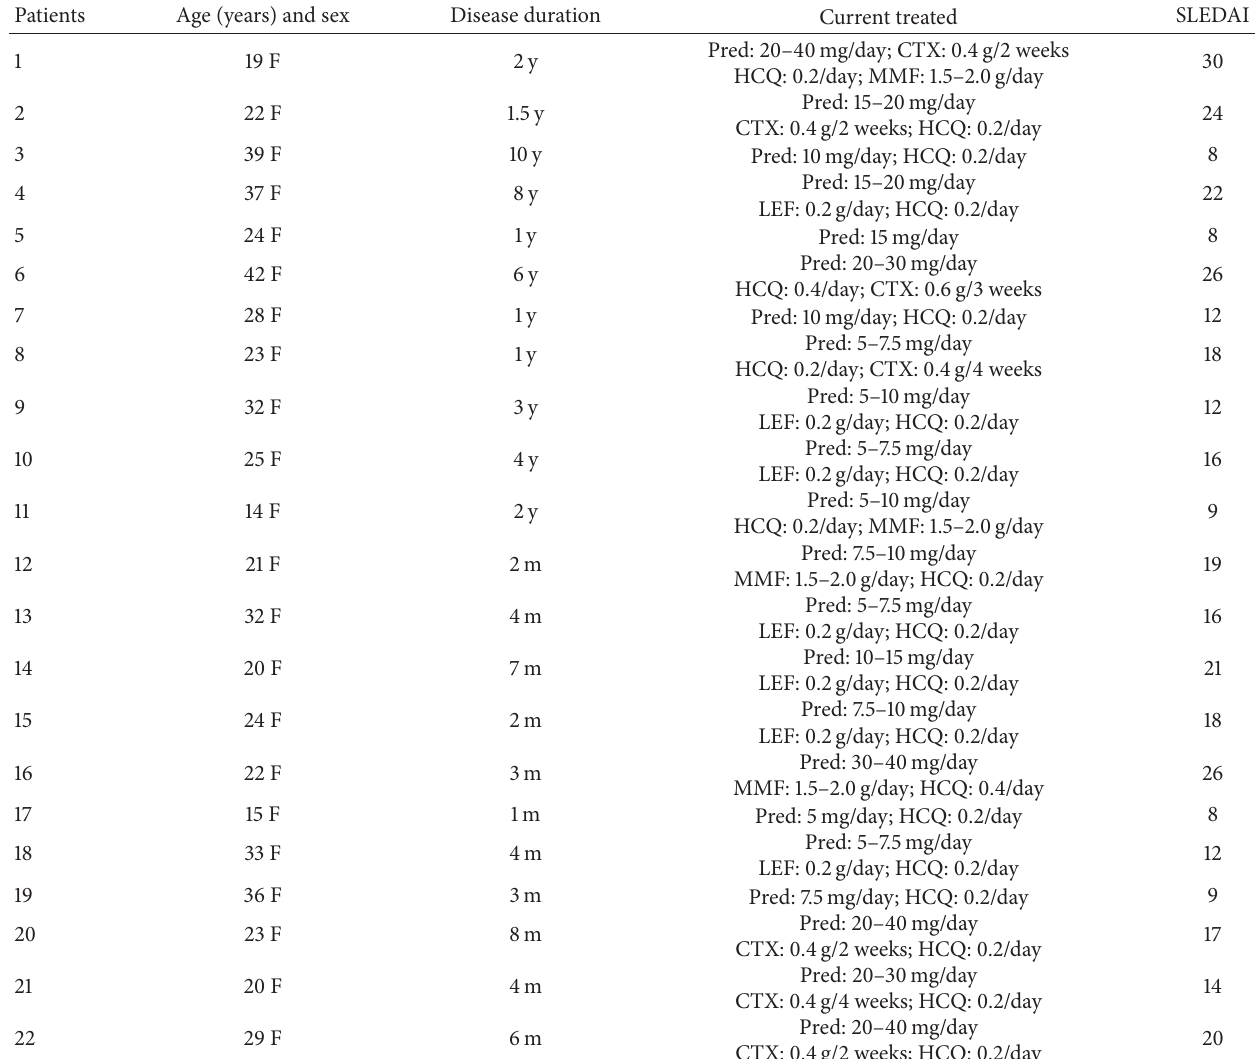
Table 1: Clinical features of 22 SLE